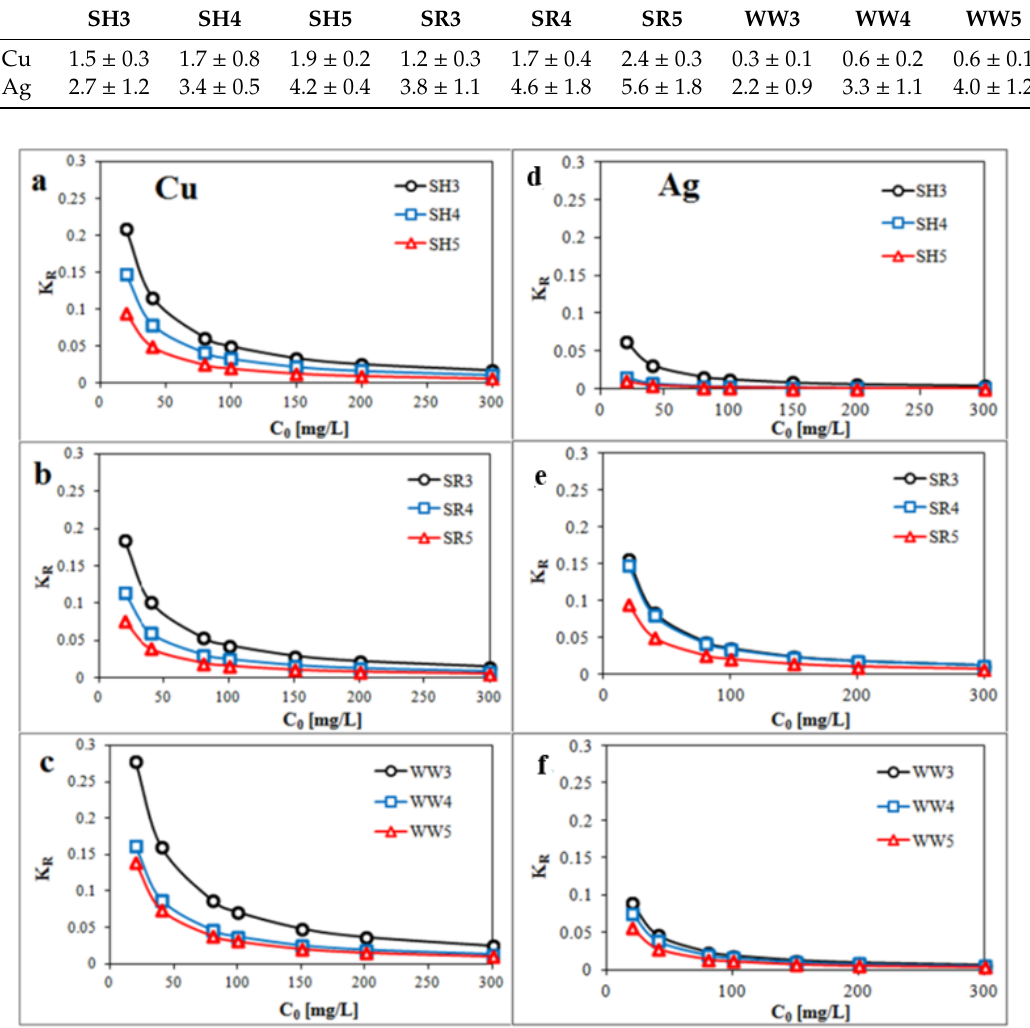
Figure 5. Plot of K R (dimensionless constant separation factor) against the initial concentration C o ( a , d ) biochar derived from sunflower husks; ( b , e ) biochar derived from sunflower husks and